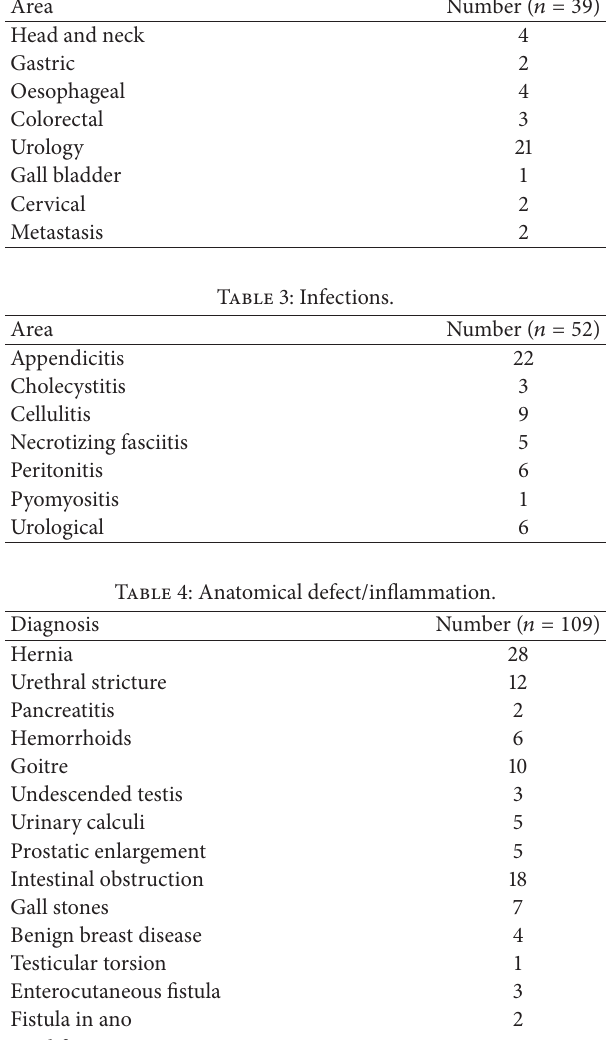
Table 2: Oncology.